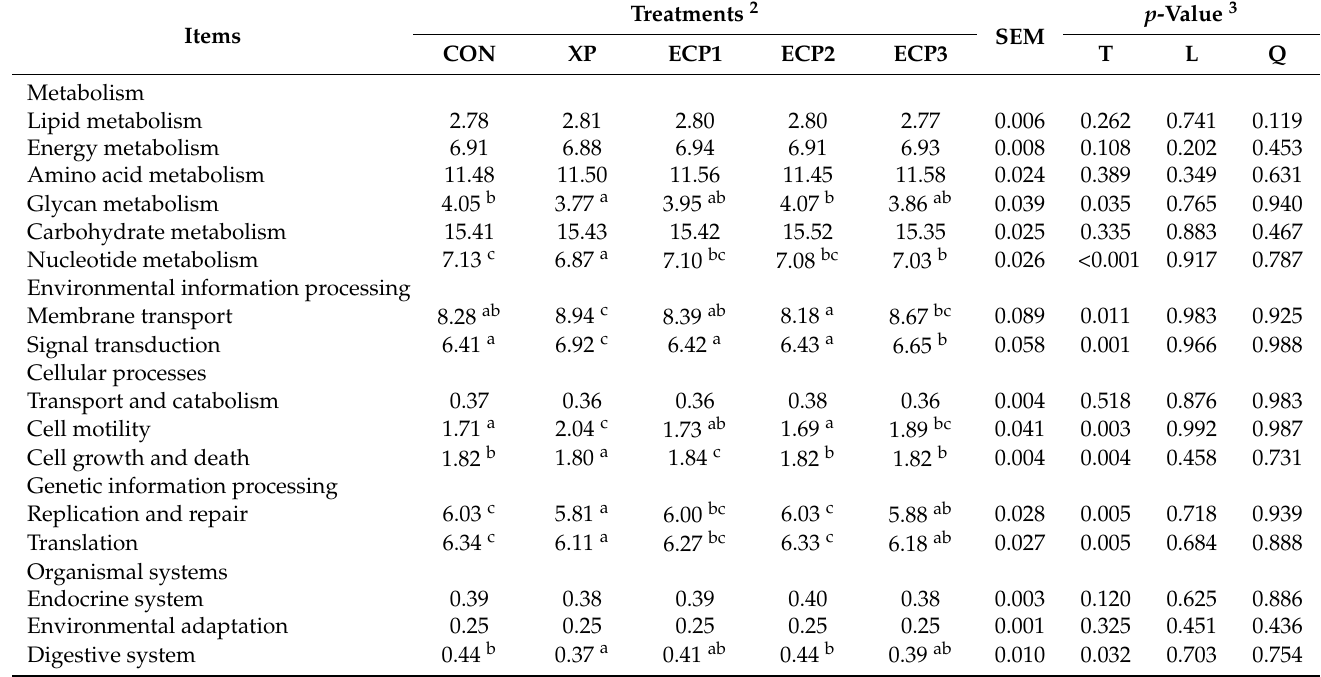
Table 7. The prediction of rumen bacterial function (%) 1